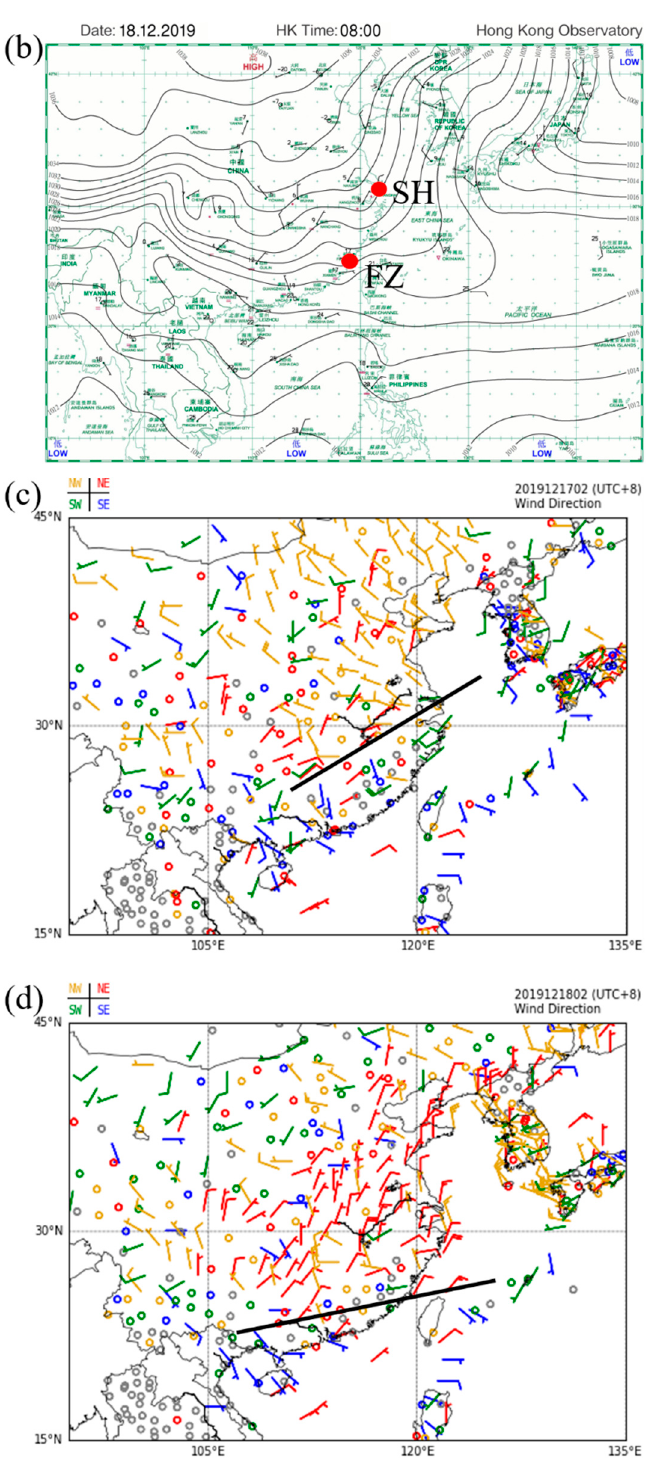
Figure 2. Panels ( a , b ) show the weather charts at 8:00 a.m. local standard time (LST) on 17 and 18 December 2019, respectively. Panels ( c , d ) show the spatial distributions of wind conditions (wind barbs) from ground weather stations over East Asia at 2:00 a.m. LST on 17 and 18 December 2019, respectively. Black straight lines represent the locations of the cold front.